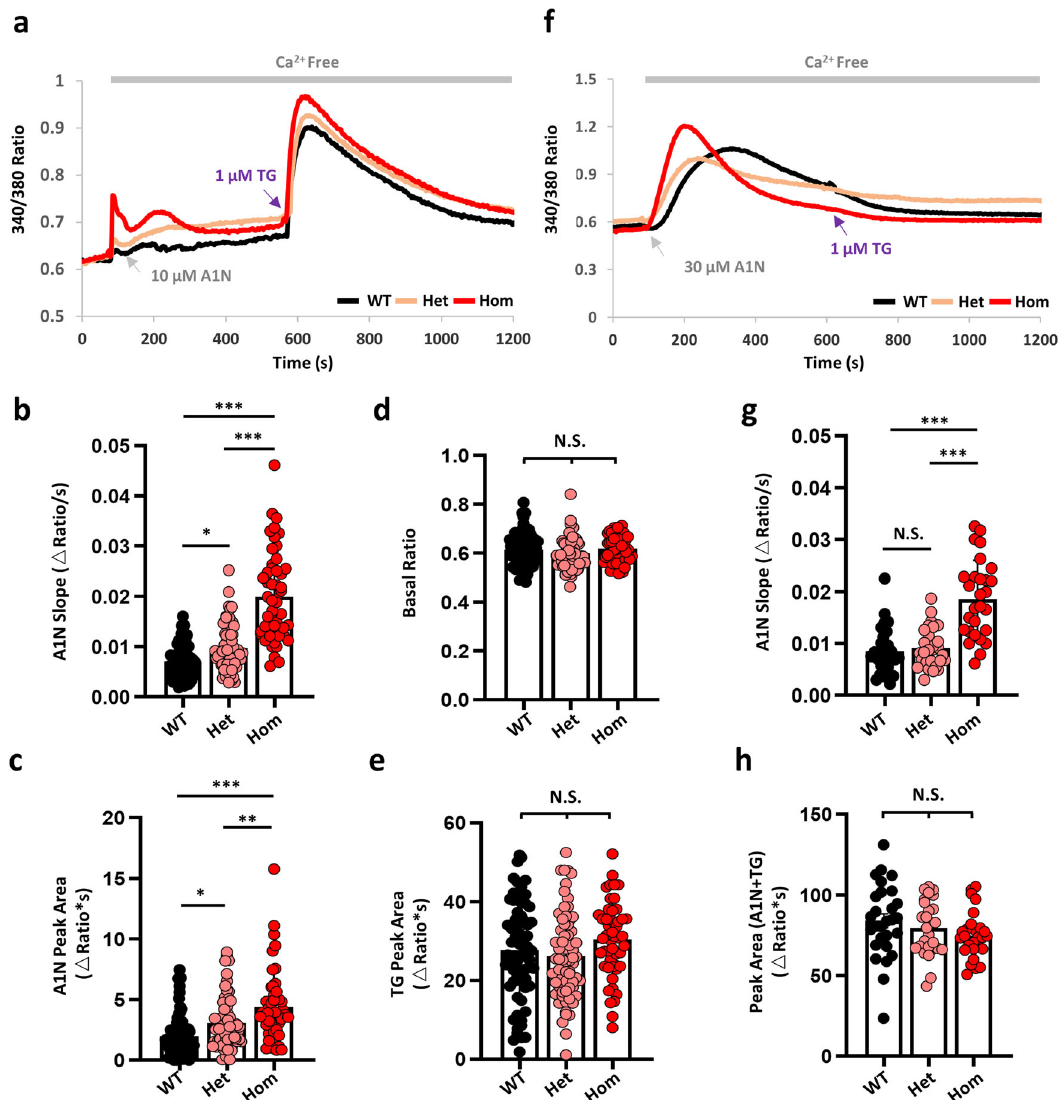
Fig. 7 | Tpcn2 R194C knock-in (KI) mouse embryonic fi broblasts (MEFs) show enhancedlysosomalCa 2+ release.a Averageratio(340/380nm)tracesofFura2in WT, Het and Hom KI MEF cells in response to sequential treatments of a speci fi c TPC2agonist,A1N(10 µ M,grayarrow)andendoplasmicreticulum(ER)Ca 2+ ATPase inhibitor, TG (1 µ M, purple arrow) in a nominally Ca 2+ -free extracellular solution. b Statisticsofslopeoftheinitial[Ca 2+ ] cyt increaseinducedby10 µ MA1N,calculated by dividing the peak ratio with the time to reach the peak (in Δ Ratio/s). WT: 0.0071±0.0004, n =74; Het: 0.0098±0.0006, n =67; Hom: 0.0200±0.0013, n =50. c Statistics of peak area (PA) for the response to 10 µ M A1N between 100s and 580s (in Δ Ratio*s). WT: 2.00±0.19, n =74; Het: 3.06±0.25, n =67; Hom: 4.39±0.41, n =50. d StatisticsofbasalFura2ratioaveragedfromthe fi rsttenratios. WT: 0.613±0.008, n =74; Het: 0.599±0.008, n =67; Hom: 0.618±0.008, n